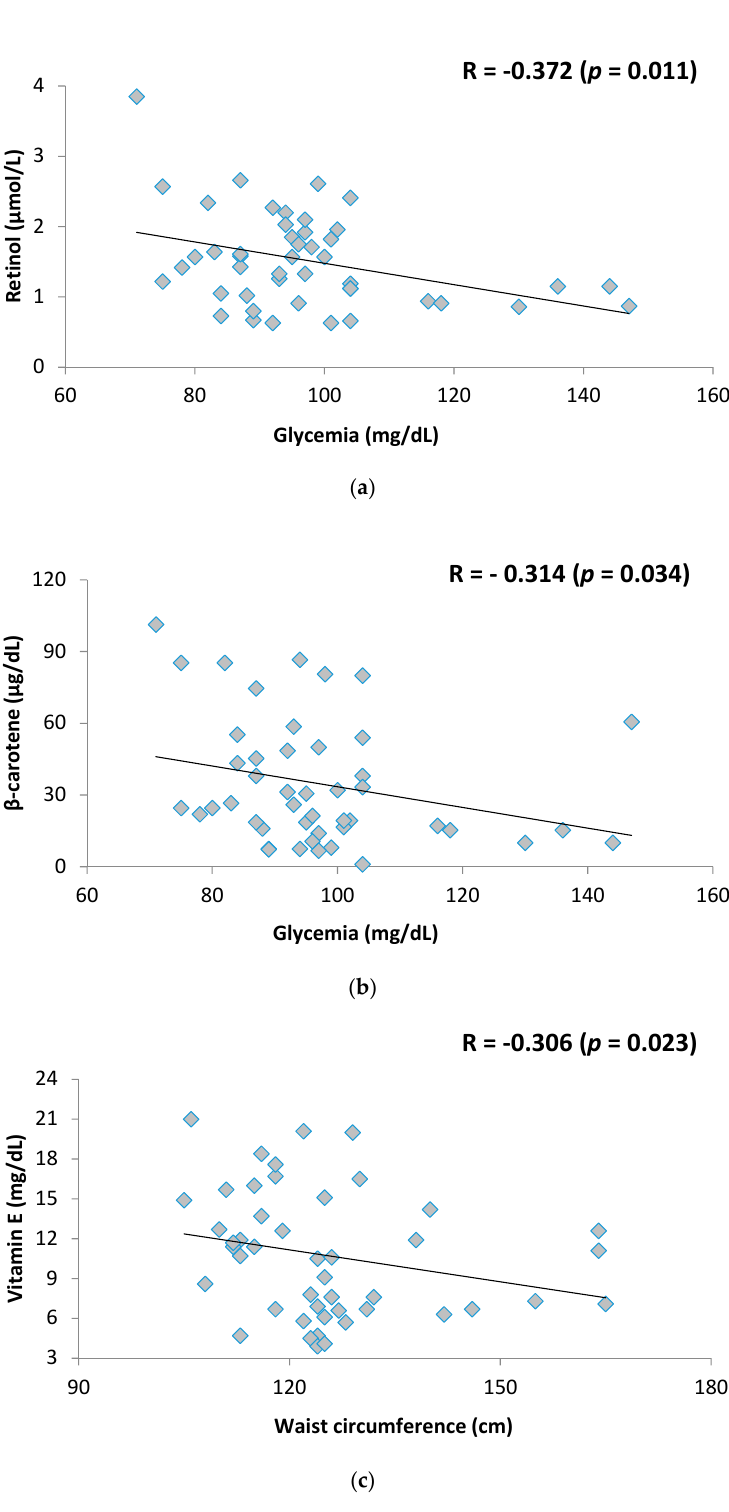
Figure 1. ( a ) Association between retinol and glycemia in metabolically unhealthy obese (MUO) adolescents; ( b ) Association between β -carotene and glycemia in MUO adolescents; ( c ) Association between Vitamin E and waist circumference (WC) in MUO adolescents.